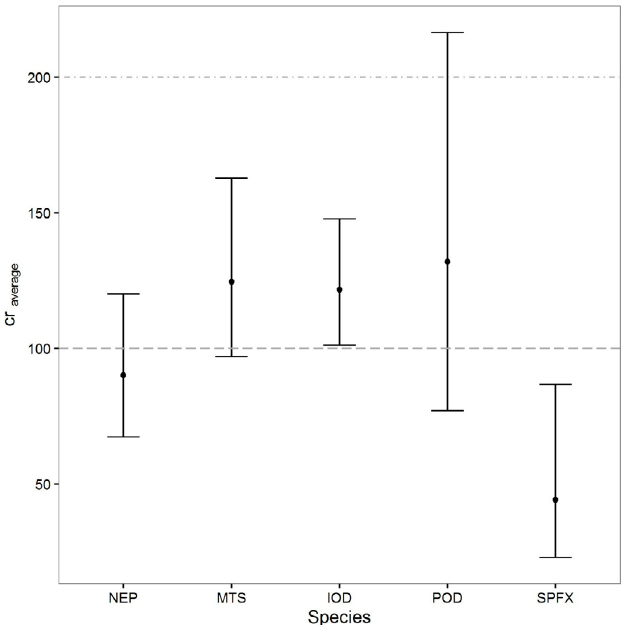
Fig. 6. Estimated values of average catch ratiofor longlinessoaked for one and two days, withone day soak time asa baseline.Horizontal dark greydashedlinesrepresentbaselinesfornoeffectofsoakingtimeonthe catchperformance.Horizontaldarkgreydot-dashedlinerepresentsline where longlines soaked for two days are catching twice as much as longlines soaked for one day. NEP: Norway lobster; MTS: mantis shrimp;IOD:blue-legswimmingcrab;POD:poorcod;SPFX:blotched